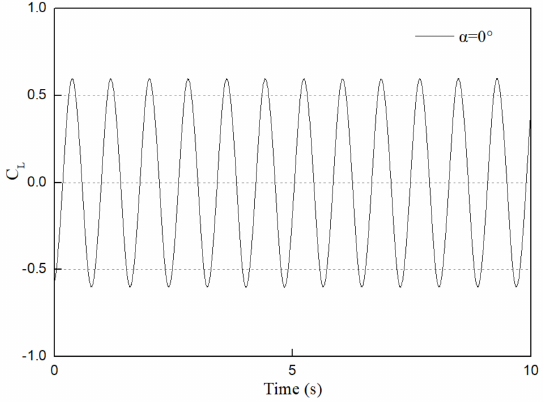
Figure 20. C L of flow around a round-ended pier with α = 0 ◦